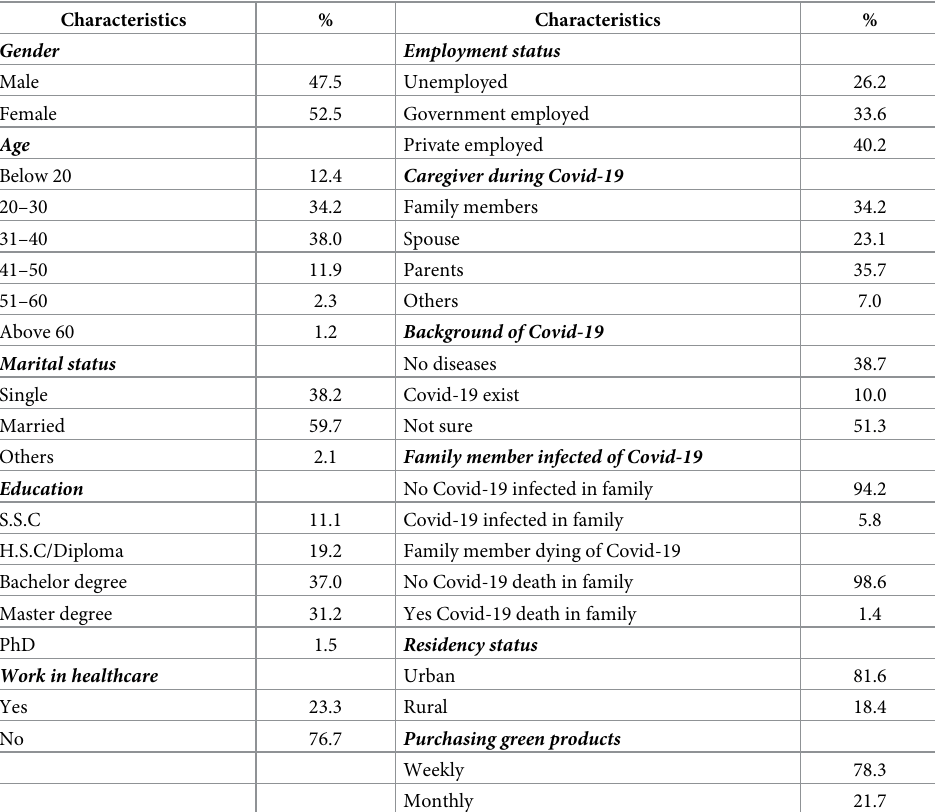
Table 1. Demographic